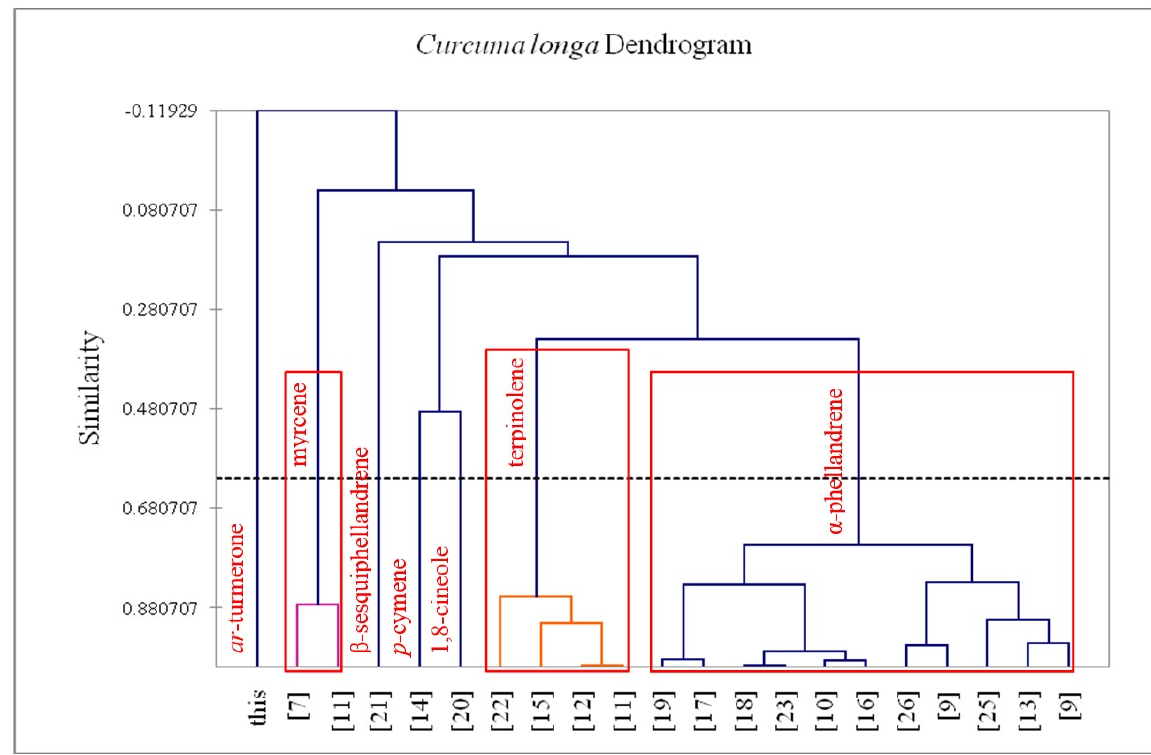
Figure 1. Dendrogram obtained from the agglomerative hierarchical cluster analysis of 21 Curcuma longa leaf essential oil samples